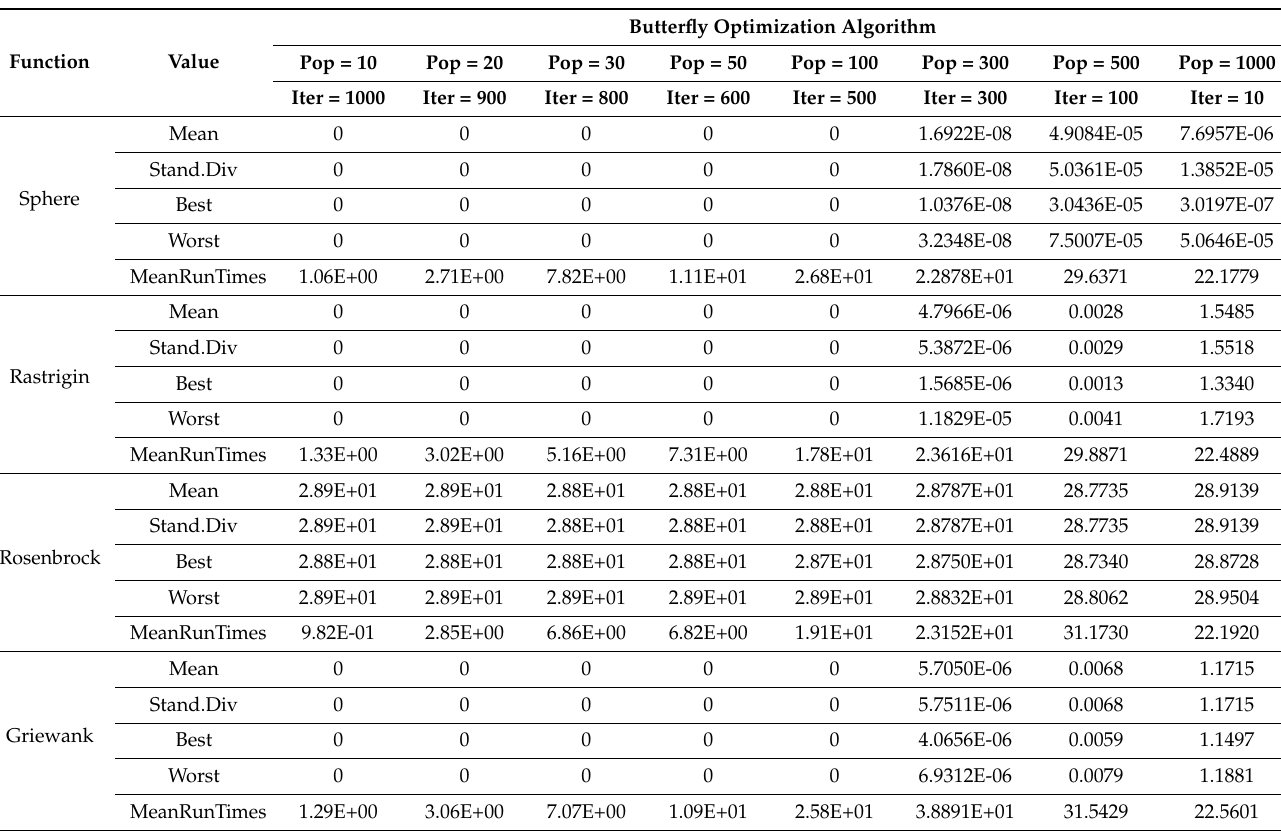
Table 15. Result for Butterfly Optimization Algorithm.